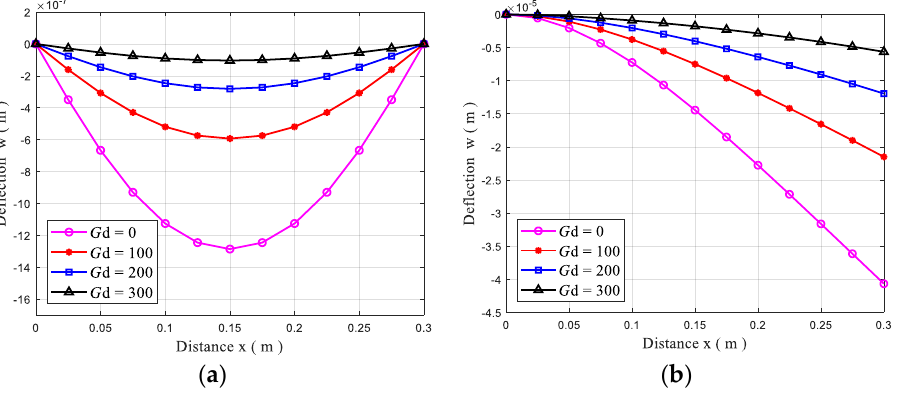
G : ( a ) a SSSS plate; ( b ) a CFFF plate. Figure 13. Static bending control of FGPs through the gain G d : ( a ) a SSSS plate; ( b ) a CFFF d